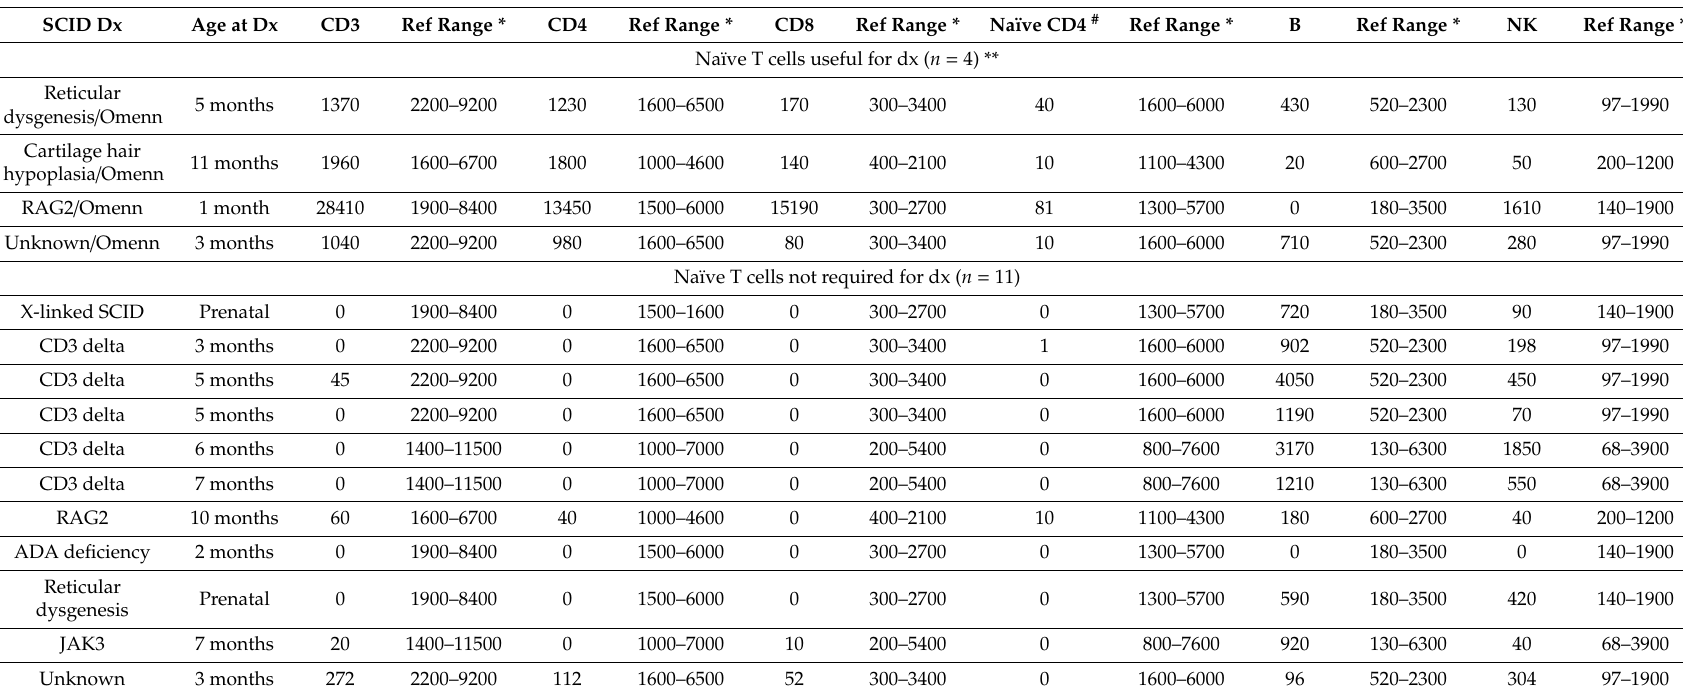
Table 7. Utility of measurement of CD4 + CD45RA + T cells in the diagnosis of SCID, Alberta, Canada cohort